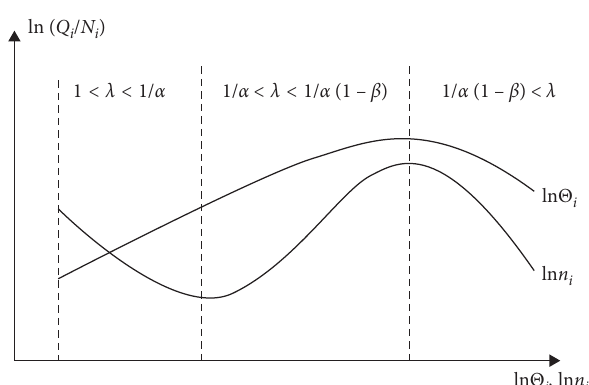
Figure 1: Static analysis diagram of ln Θ